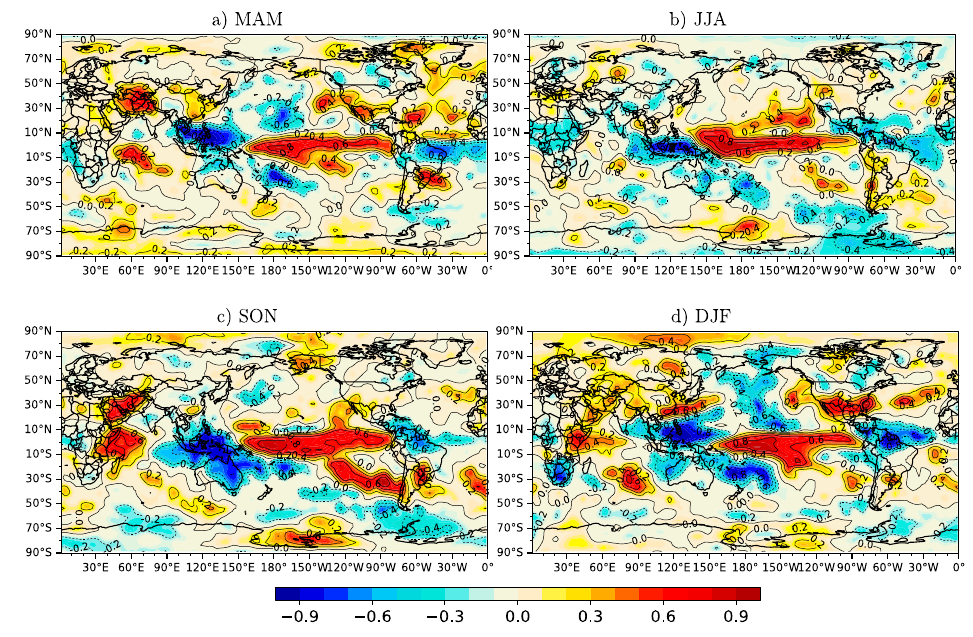
Figure 2. Standardized predictable covariances for GPCP precipitation with Nino3-4 SST.